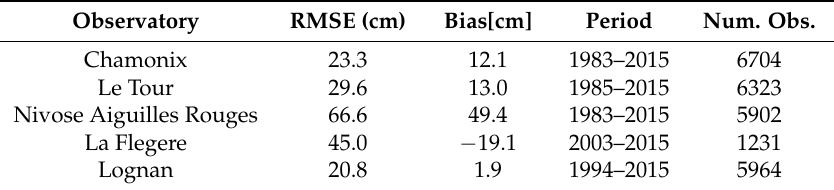
Table 1. Error statistics (bias and Root Mean Squared Error (RMSE)) between simulated and in situ snow depth observations for the five meteorological stations in the study area for periods for which observations were available. The locations of the stations are shown in Figure 1.